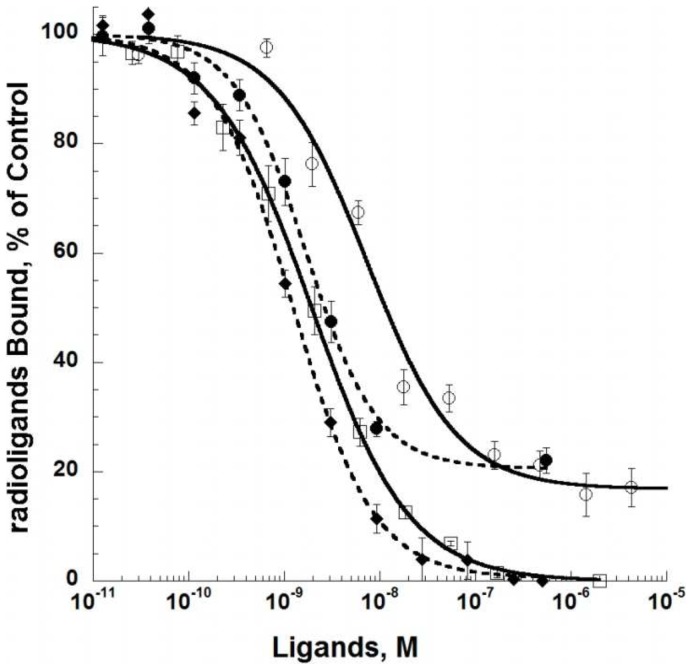
Inhibition of 3H-prazosin (2 nM, 1 µg, open symbols) by HEAT (□), and ρ-Da1a (circle), and inhibition of 125I-HEAT (0.2 nM, 0.2 µg, full symbols) binding by prazosin (♦) and ρ-Da1a (circle) to α1A-AR.n = 3.